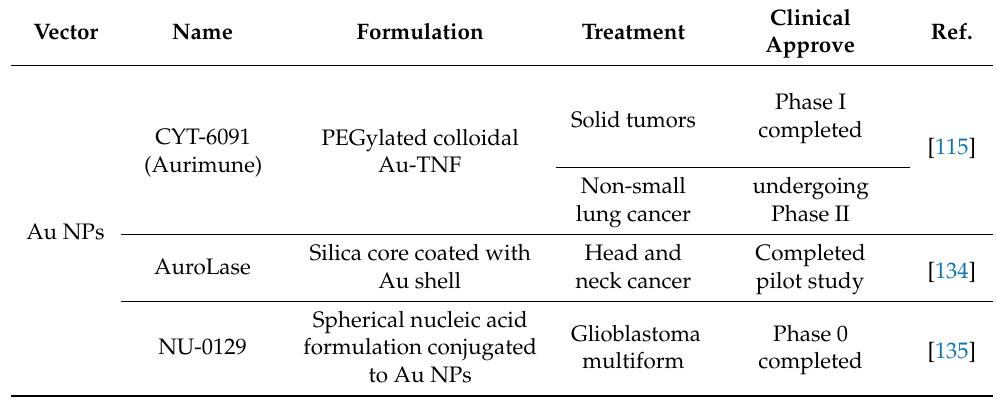
Table 2. List of Au NPs for cancer therapy undergoing clinical trials and approved by EMA or FDA.